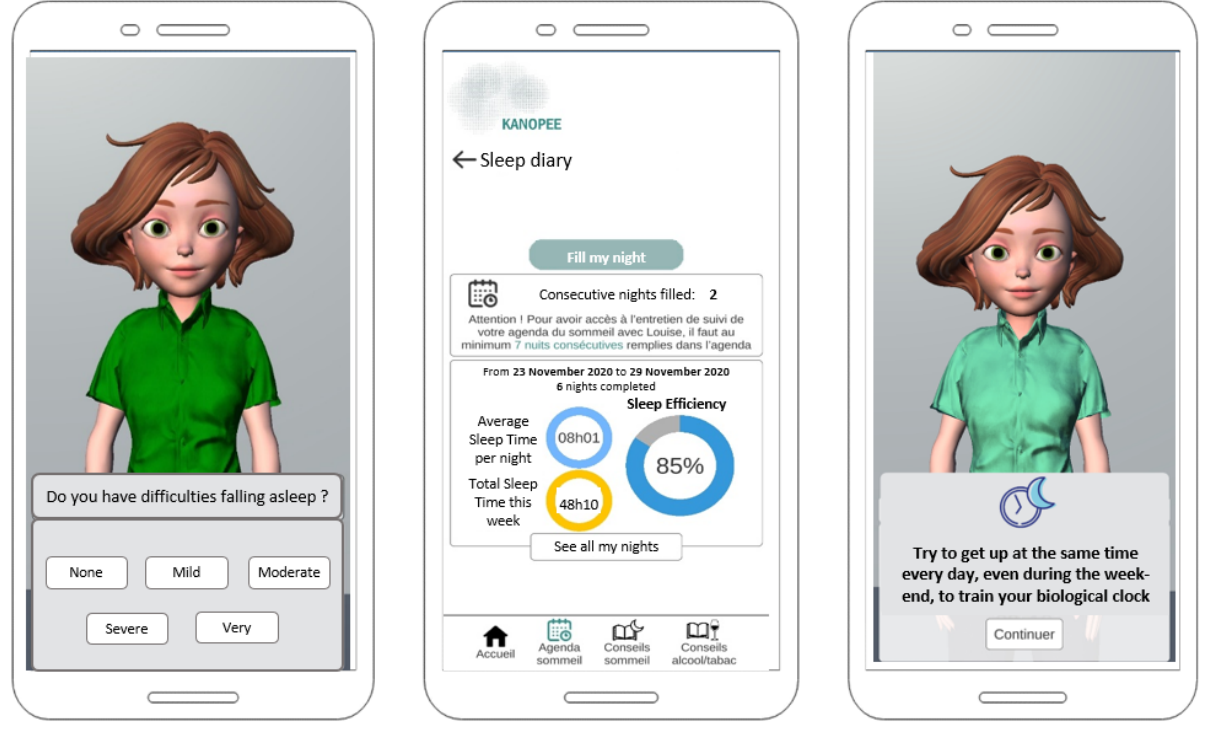
Figure 2. Illustrative references of KANOPEE app interfaces. From left to right, screenshot of (1) virtual agent Louise conducting an interview based on the Insomnia Severity Index, (2) sleep diary and visual feedbacks regarding user’s sleep patterns, and (3) a personalized sleep recommendation given by Louise during Interview